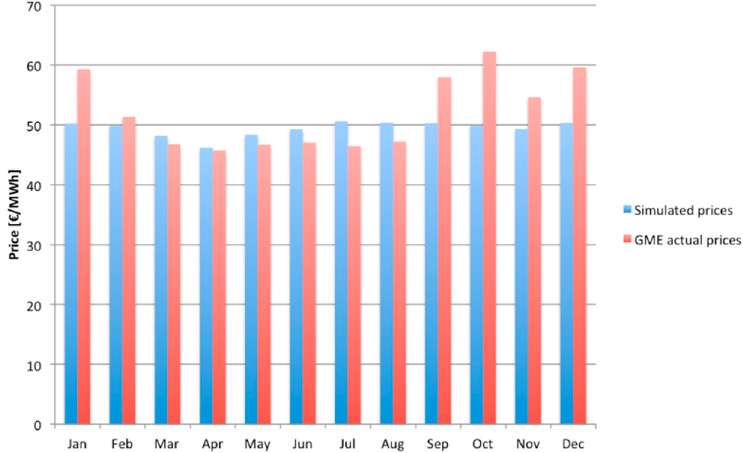
Figure 10. Average monthly prices: comparison between simulated and actual values.